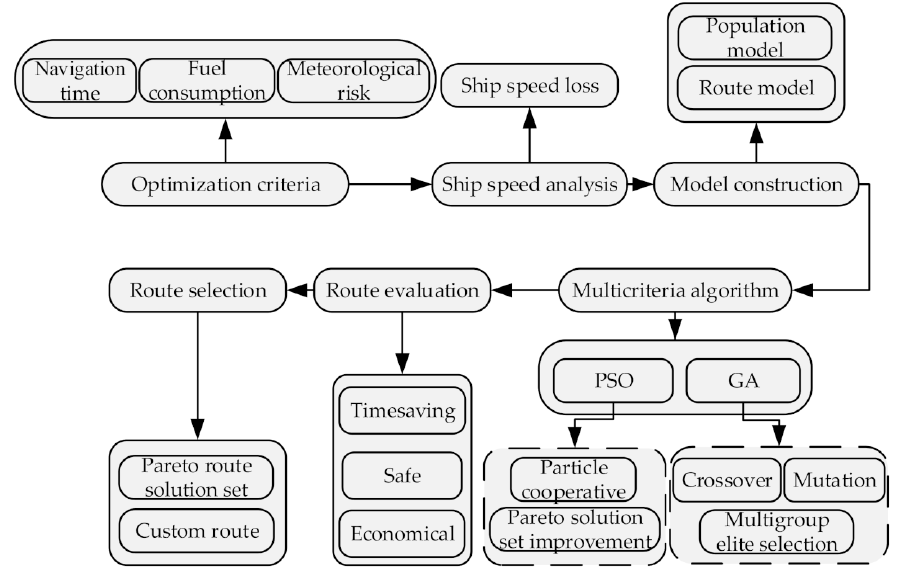
Figure 1. Multicriteria route planning